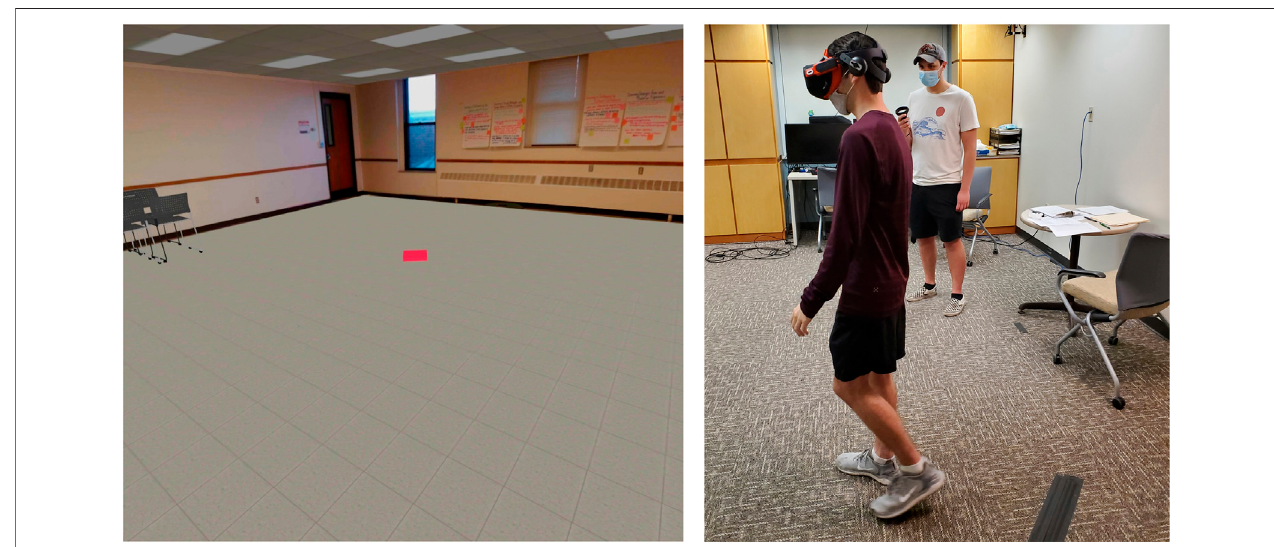
FIGURE 1 | Left: Screenshot of the virtual classroom taken from the position of the viewing location. The red square is the target object used for verbal and blind walking distance judgments. Right: Participant (foreground) and researcher (background) during a blind walking trial.